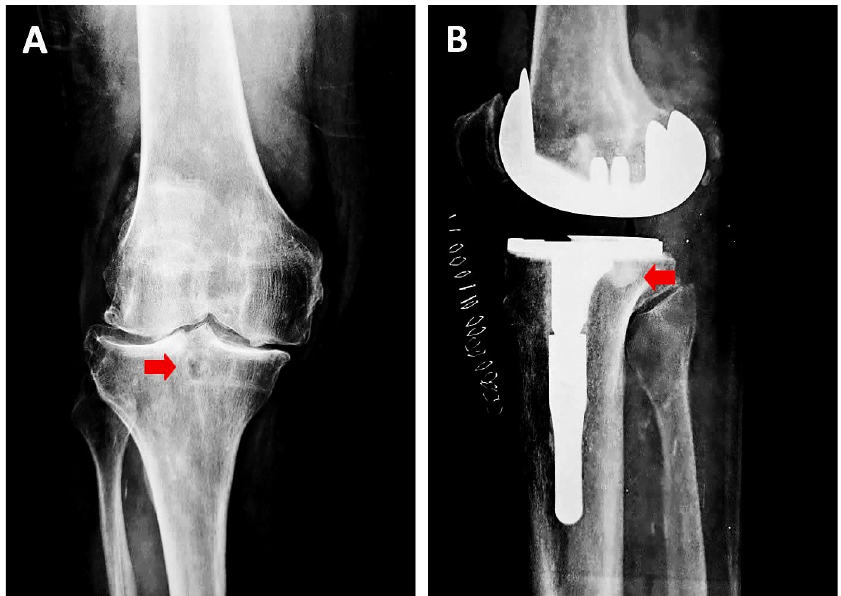
Figure 4. ( A ) Pre-operative anteroposterior radiograph of an osteoarthritic knee displaying the characteristic appearance of a subchondral bone cyst (red arrows). Note the sclerotic osseous margins ( B ): Postoperative lateral X-Ray. After subchondral cyst excision, the gap was filled with cement.